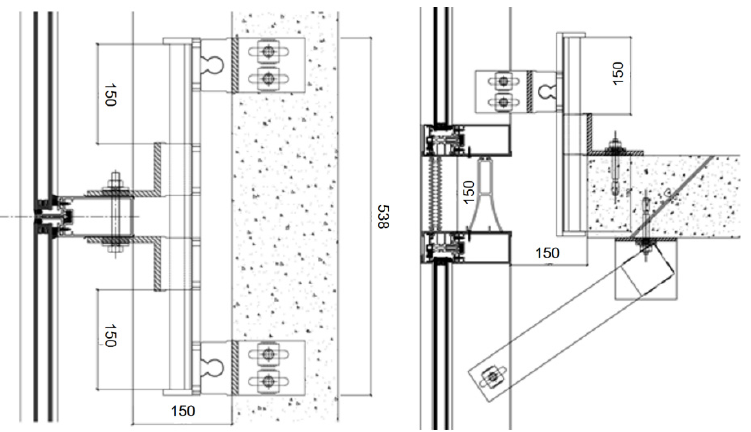
Figure 6. Developed fastener prototype design.